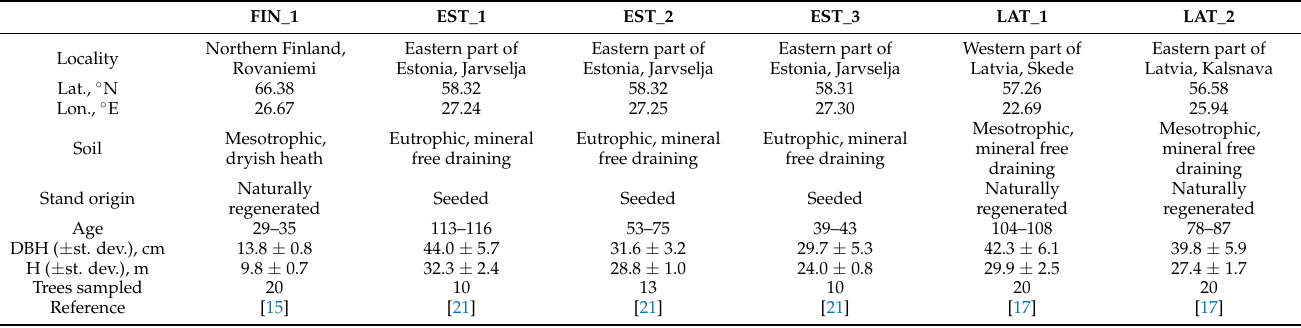
Table 1. Location and description of the studied conventionally managed stands and dimension of sampled tress used for the generalization of regional responses of height increment of Scots pine to meteorological conditions across the north-eastern Baltic Sea region. The refences of initial publication of the datasets are given. DBH—stem diameter at breast height, H—tree height. FIN_1 EST_1 EST_2